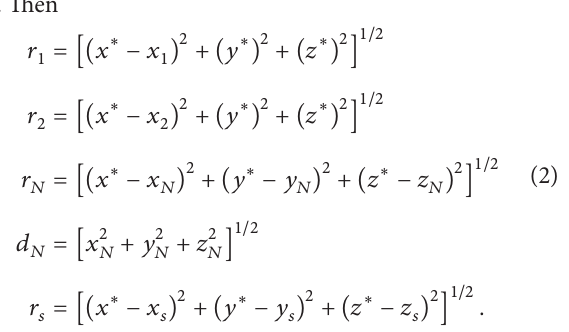
Figure 1: Diagram of 𝑁 -body problem coordinate